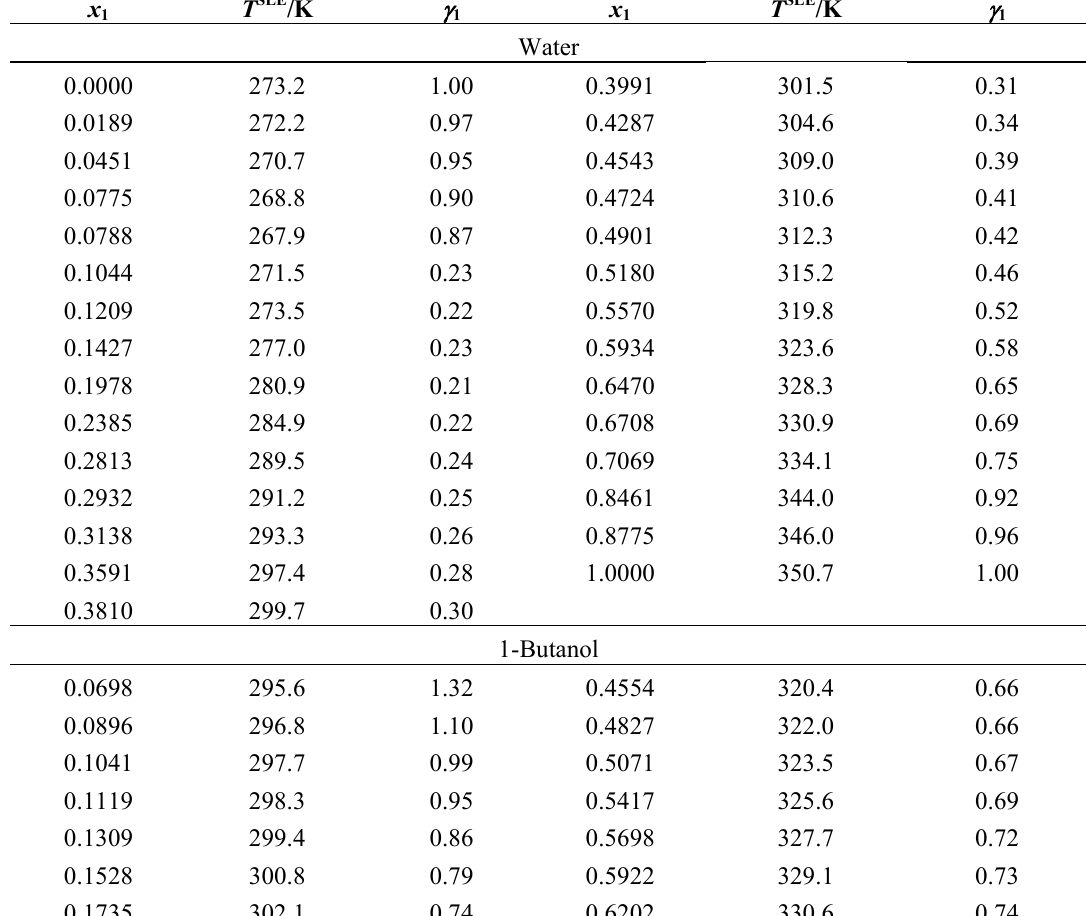
, mole fraction;  , experimental activity coefficient of the 1 1